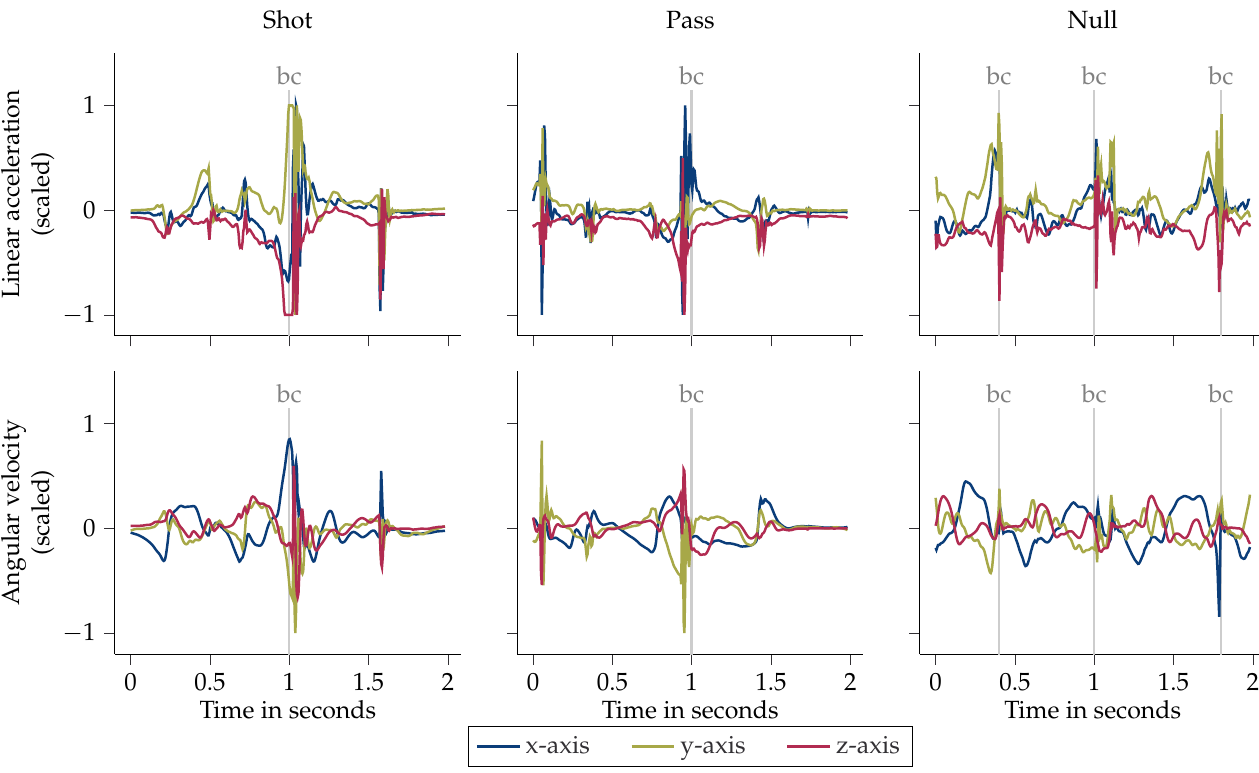
Figure 2. Exemplary IMU data for each class. Each ball contact (bc) is indicated by a vertical gray line. Sensor orientation is shown in Figure